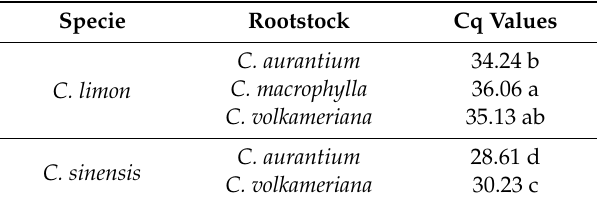
Table 2. Means comparison of quantification cycle (Cq) values of C. limon and C. sinensis developed on di ff erent rootstocks.